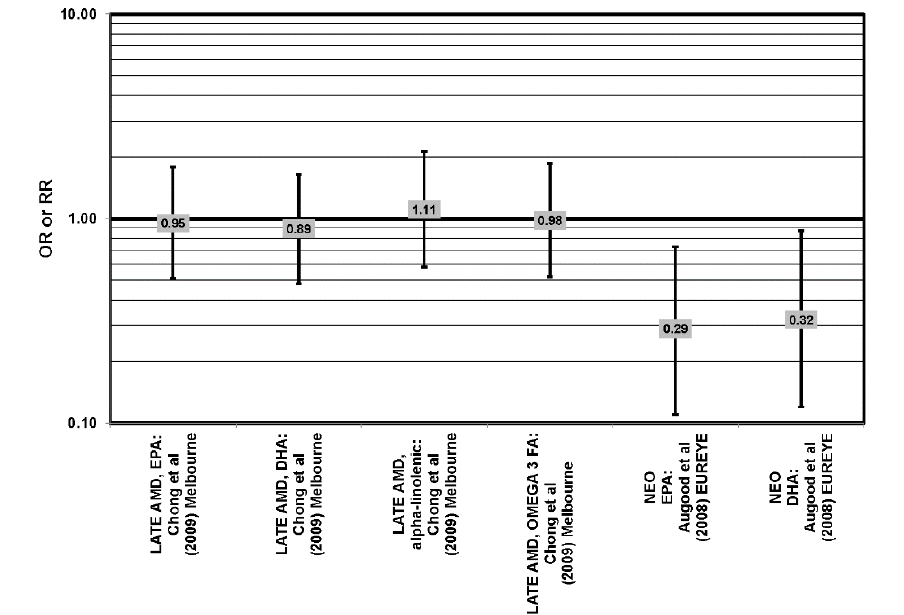
Figure 10. Odds or risk ratio for late, neo AMD; high vs. low intake of omega-3 fatty acids: prospective